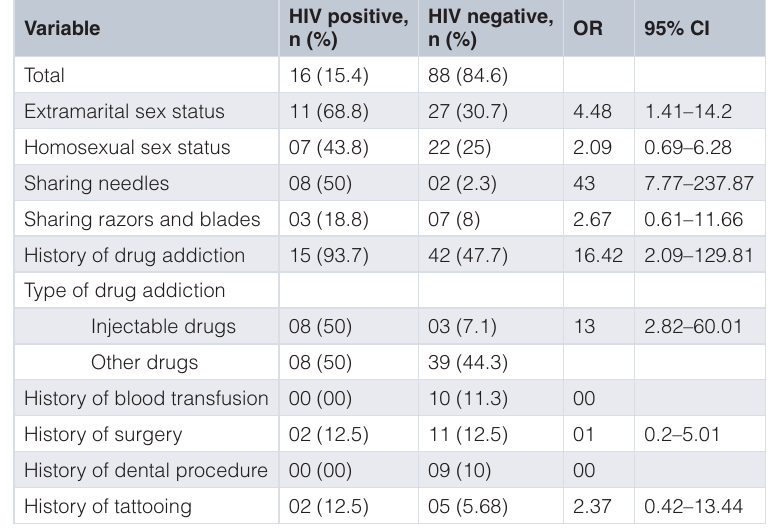
Table 3. Risk factors associated with prevalence of HIV in prisons setting of Balochistan. 2018.